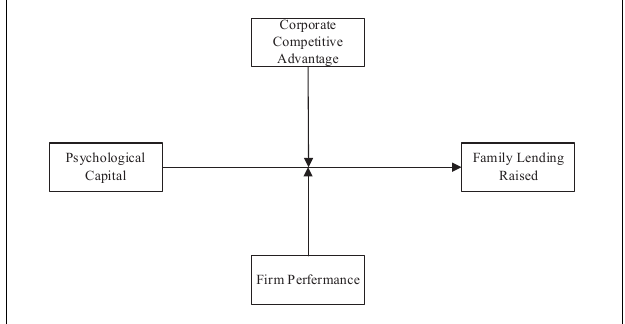
FIGURE 1 | Conceptual